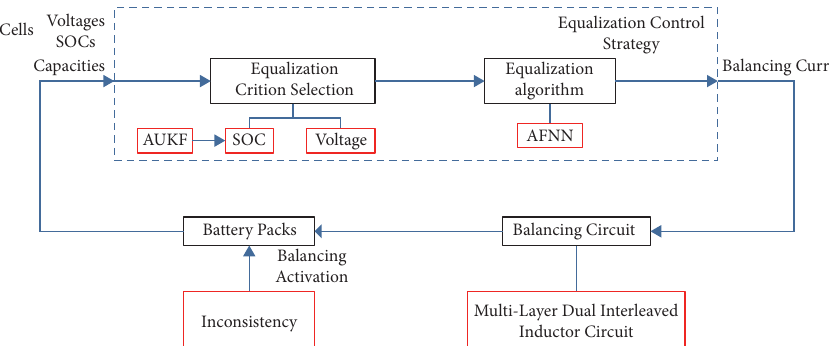
Figure 2: Overall structure of the proposed MLDIEC and its control strategy.